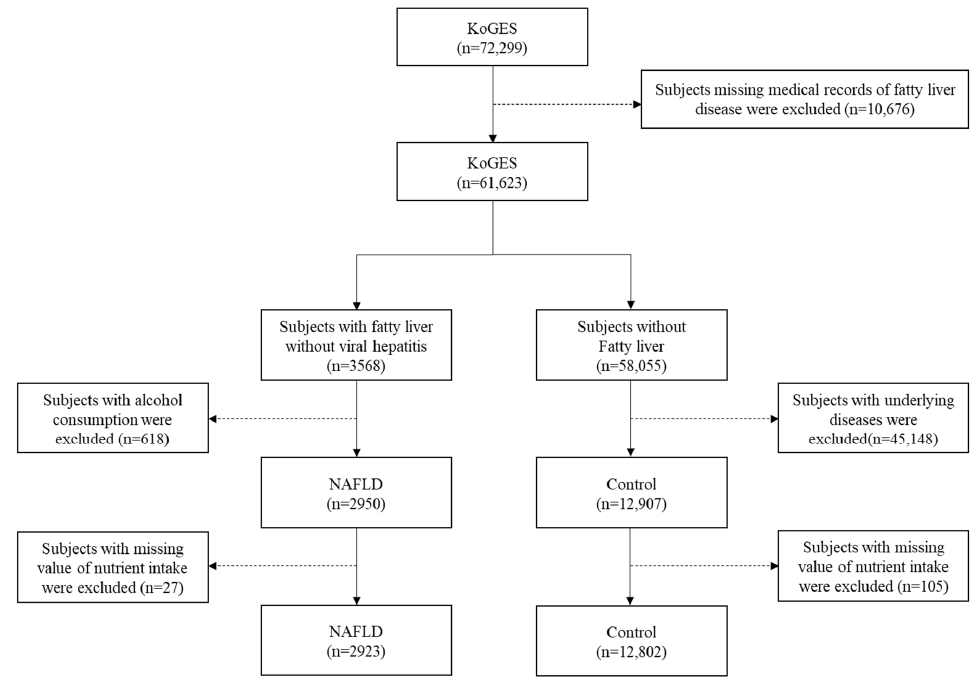
Figure 1. Study population using KoGES database. Abbreviations: KoGES, Korean Genome and Epidemiology Study; NAFLD, non ‐ alcoholic fatty liver disease. Table 1. Baseline characteristics of the study population.